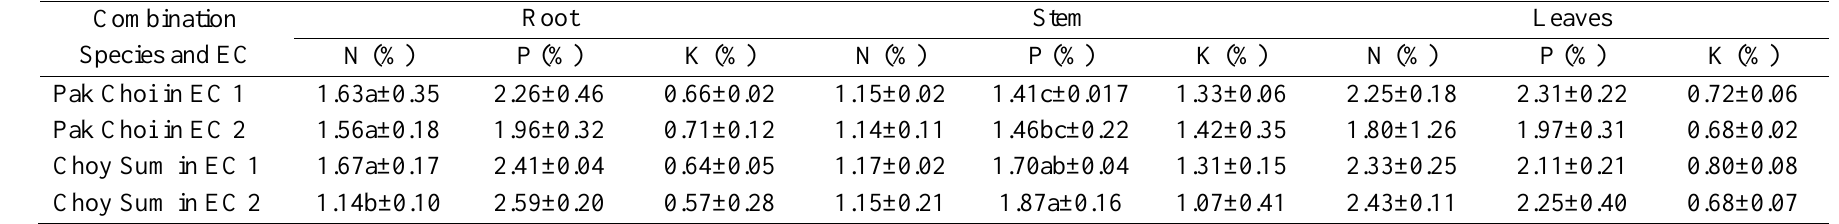
Table 3. N, P, K uptake (%) from root, stem and leaves Combination Species and EC